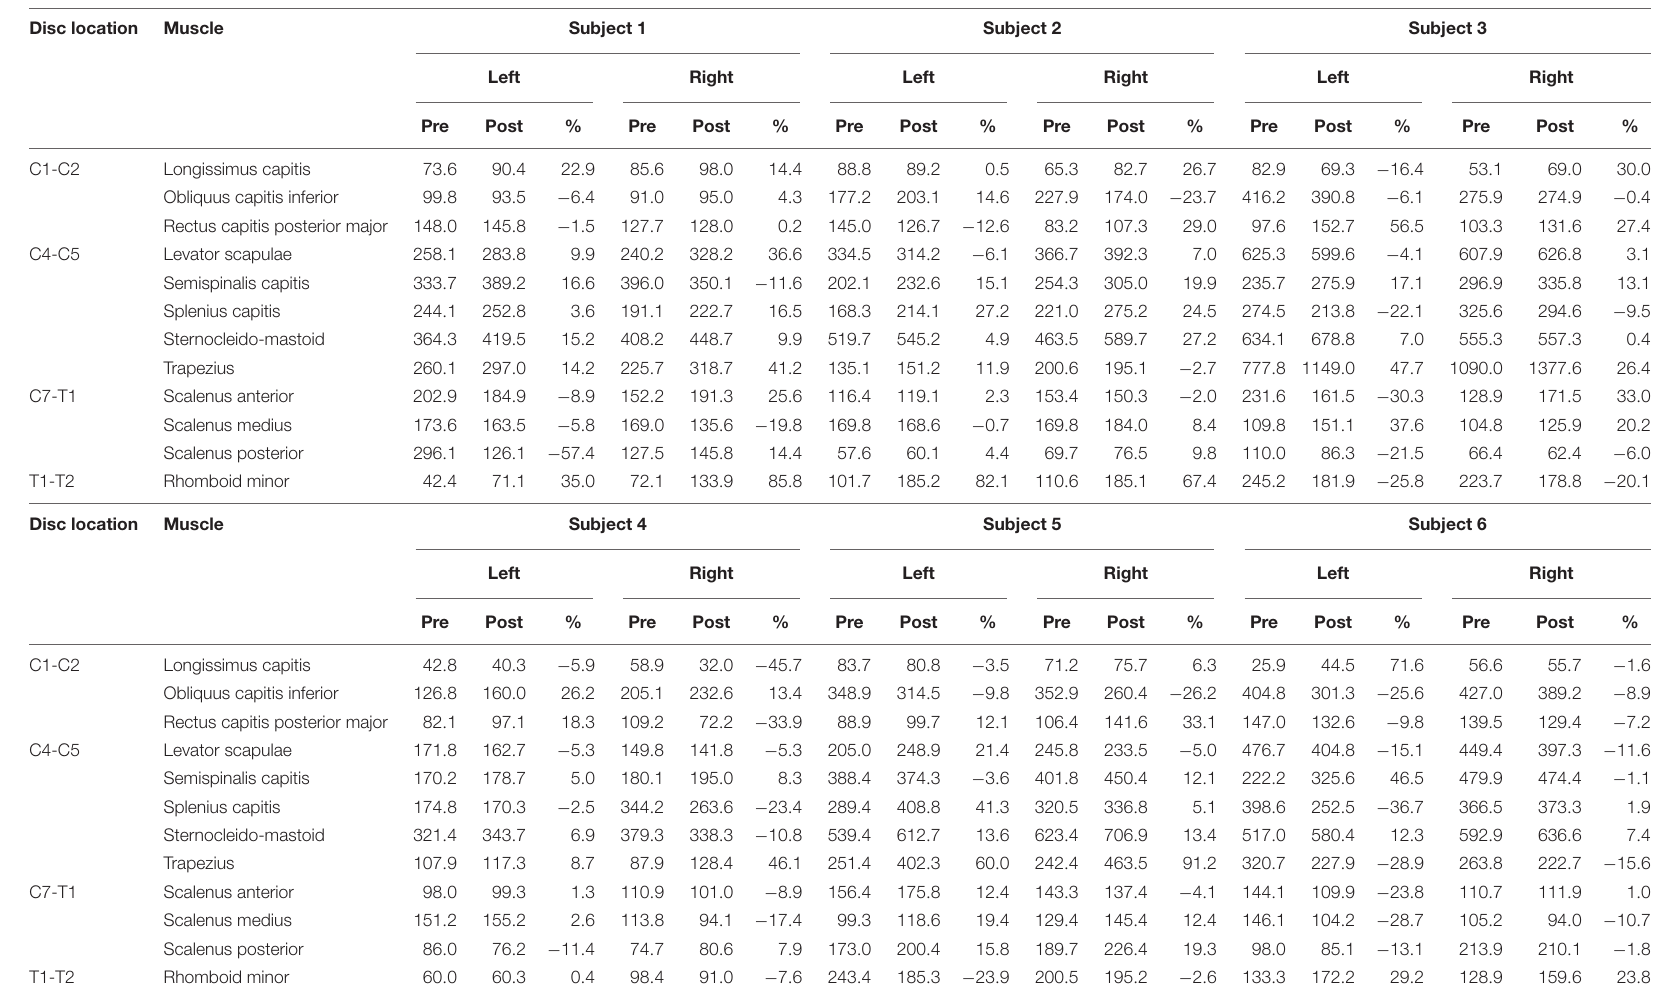
TABLE 2 | Absolute (mm 2 ) and percent changes in muscle cross-sectional area (CSA) for the six crewmembers (Subject 1–Subject